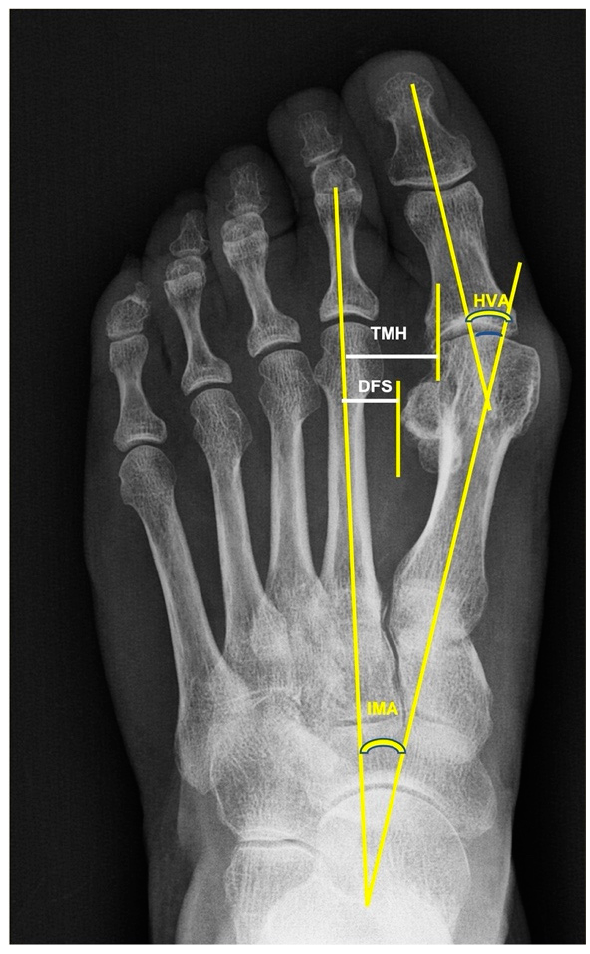
Figure 2. Radiological measures. DFS: Distance of the fibular sesamoid bone to the second metatar- sal axis. TMH: Translation of the first distal metatarsal head. HVA: Hallux valgus angle. IMA: I–II intermetatarsal angle .